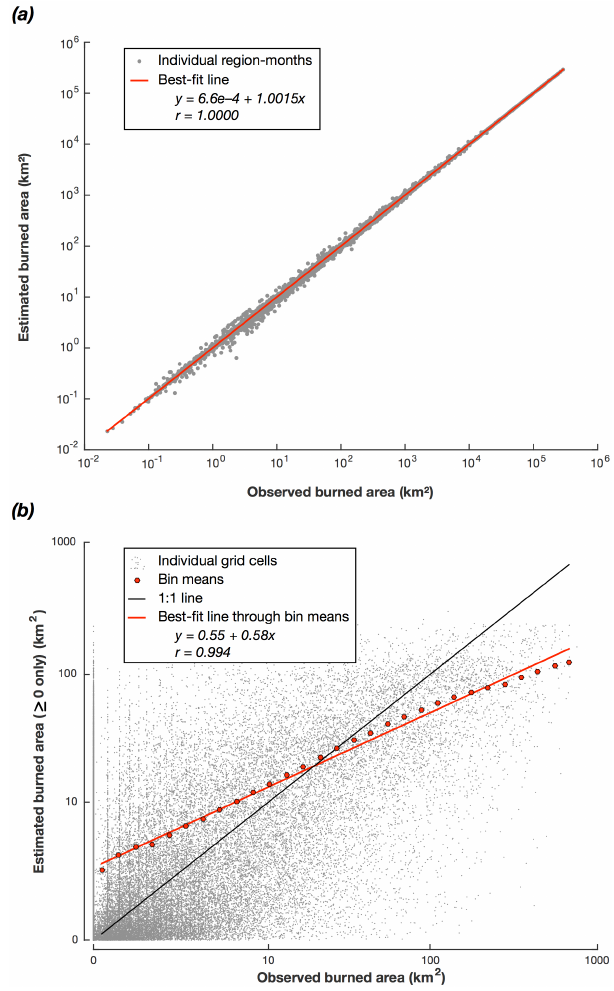
Figure 8. Scatterplots comparing estimated and observed total burned area. Gray points represent (a) each analysis region and month (region-month) or (b) individual grid cells ( 1 of cells cho- 75 sen at random for plotting). Red lines represent the best-fit line from linear regression, with the regression in (b) fit to the red points, which represent mean observed and estimated values of grid cells in bins of observed burned area equally spaced along the x axis (with at least 100 grid cells required for a bin to be included). Values ≤ 0 not shown due to log-scale axes. Grid cells in region-months with no observed fire, where the analysis was not performed, were ex- cluded from both plots and regressions. Corresponds to Fig.